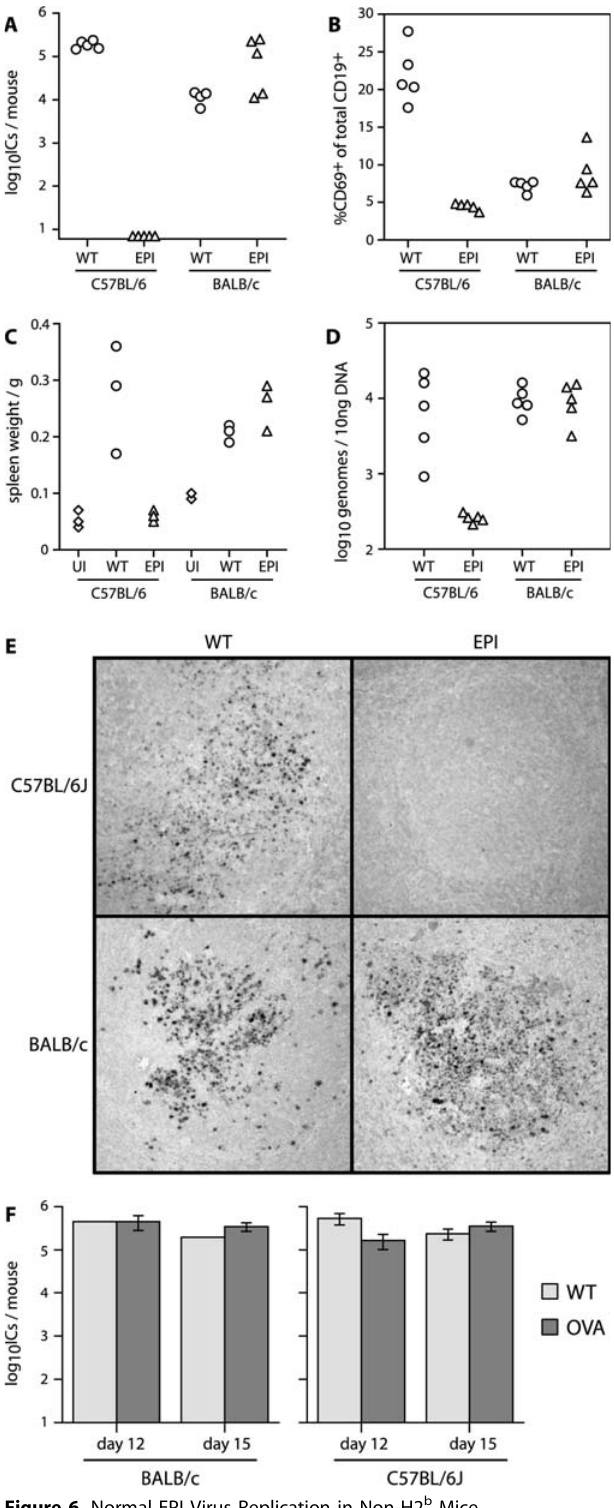
Figure 6. Normal EPI Virus Replication in Non-H2 b Mice (A) Infectious centre titres in individual spleens were determined 14 d after intranasal infection of C57BL/6J (H2 b ) or BALB/c (H2 d ) mice with WT or EPI virus. (B) CD69 expression on splenic B cells was measured by flow cytometry 14 d post-infection. B cells from uninfected mice were less than 5% CD69 þ . (C) The weights of individual spleens are shown 14 d post-infection, with spleens of age-matched, uninfected mice (UI) for